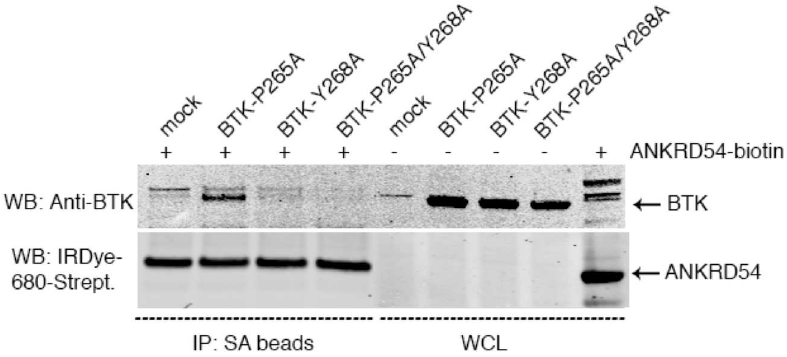
Fig 6. Residues in the 3 10 helix important for the interaction of ANKRD54to BTK. Cos7 cells were separately transfected with ANKRD54-wt and the followingBTK-SH3 mutants: P265A, Y268A and P265A/ Y268A. The obtainedlysates were mixed and processedfor immunoprecipitation.